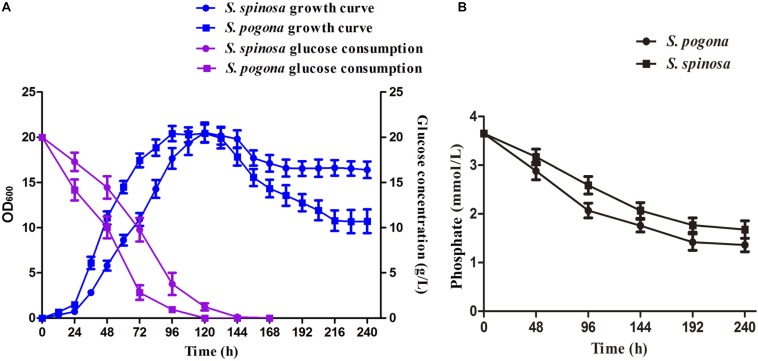
Comparison of growth characteristics between S. pogona and S. spinosa. (A) Growth kinetics and glucose consumption analysis. (B) Determination of phosphate in SFM.